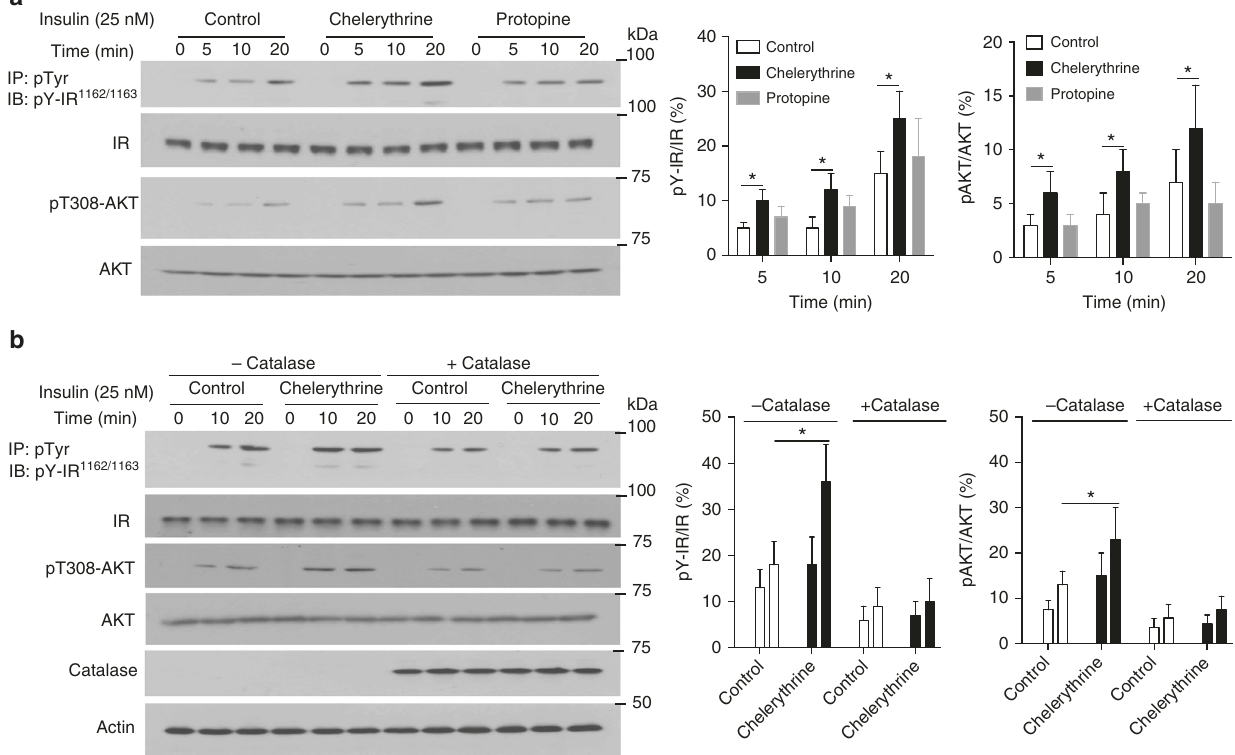
Fig. 6 Chelerythrine enhanced insulin signaling in a redox-dependent manner. a Untreated cells and cells treated with chelerythrine (2 μ M) or protopine (2 μ M) for 1 h, were stimulated with insulin (25 nM) for the indicated times, following which cells were lysed and lysates were used to study insulin signaling by immunoblot analysis. b Cells that transiently express catalase or vector control were untreated or treated with chelerythrine (2 μ M) and stimulated with insulin (25 nM) for the indicated times, following which cells were lysed and lysates were used to study insulin signaling by immunoblot analysis. All immunoblots are representative of three independent experiments ( n = 3). Immunoblots were quanti fi ed using ImageJ software. Quantitation includes the data from all experiments and is presented as the mean ± s.e.m. Statistical analysis was performed using two-sided Students t -test (* p <